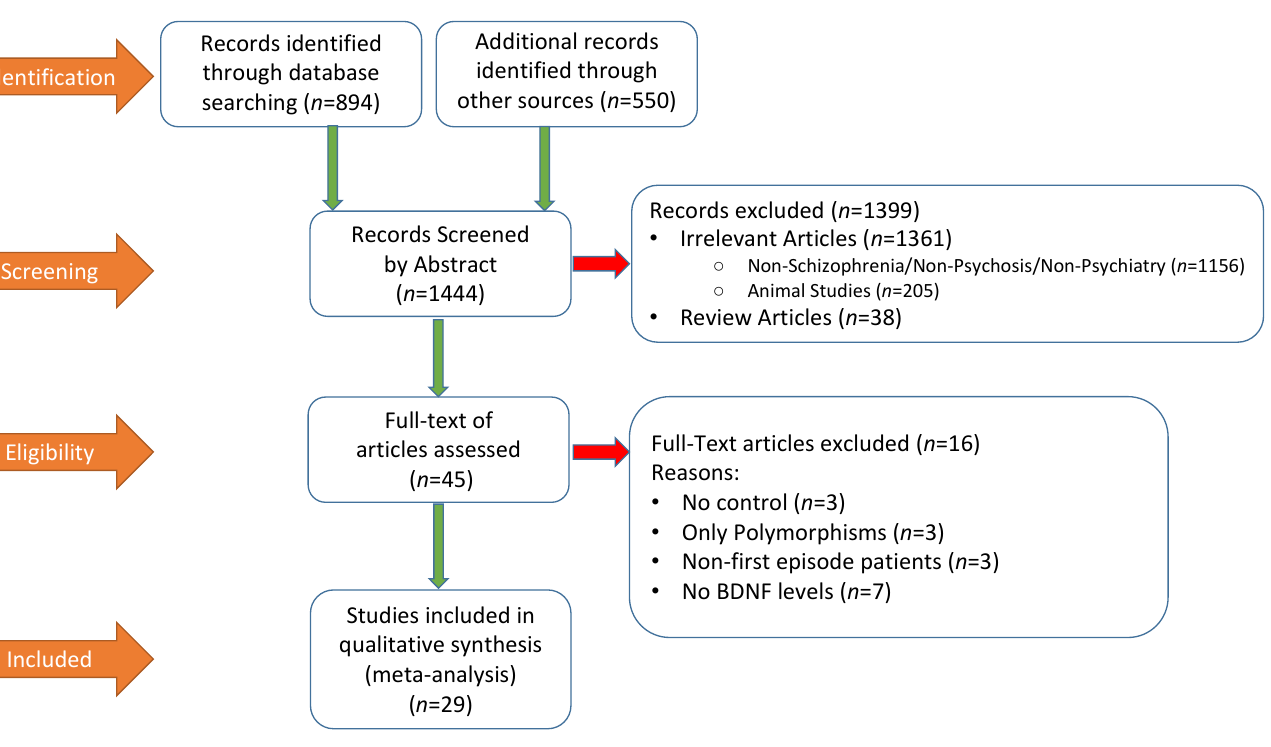
Figure 1. Preferred Reporting Items for Systematic Reviews and Meta-Analyses (PRISMA) flow diagram of literature search procedure and results.